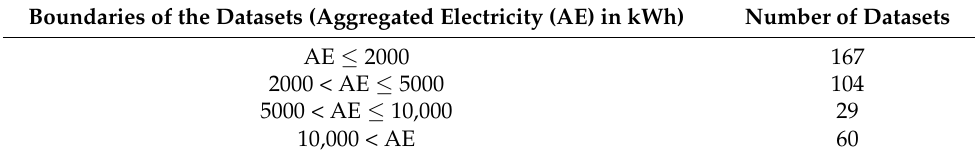
Table 1. Cluster boundaries and number of datasets in each